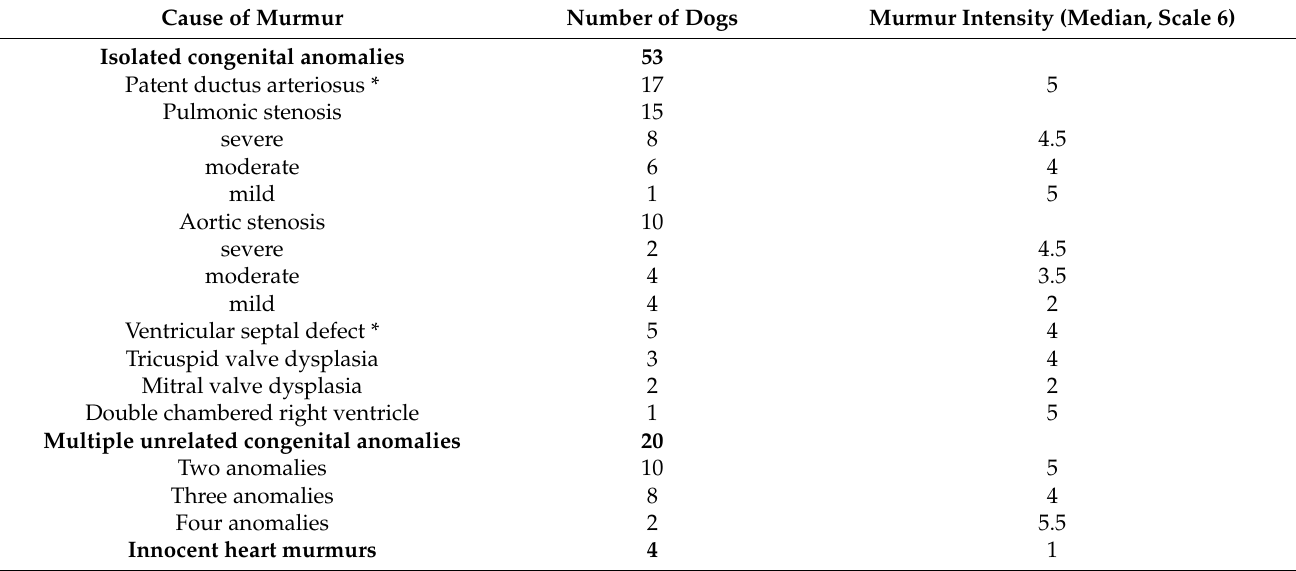
Table 1. Type of congenital heart diseases and the associated murmur intensity found in the 77 dogs that were presented to the authors’ cardiology service in the study